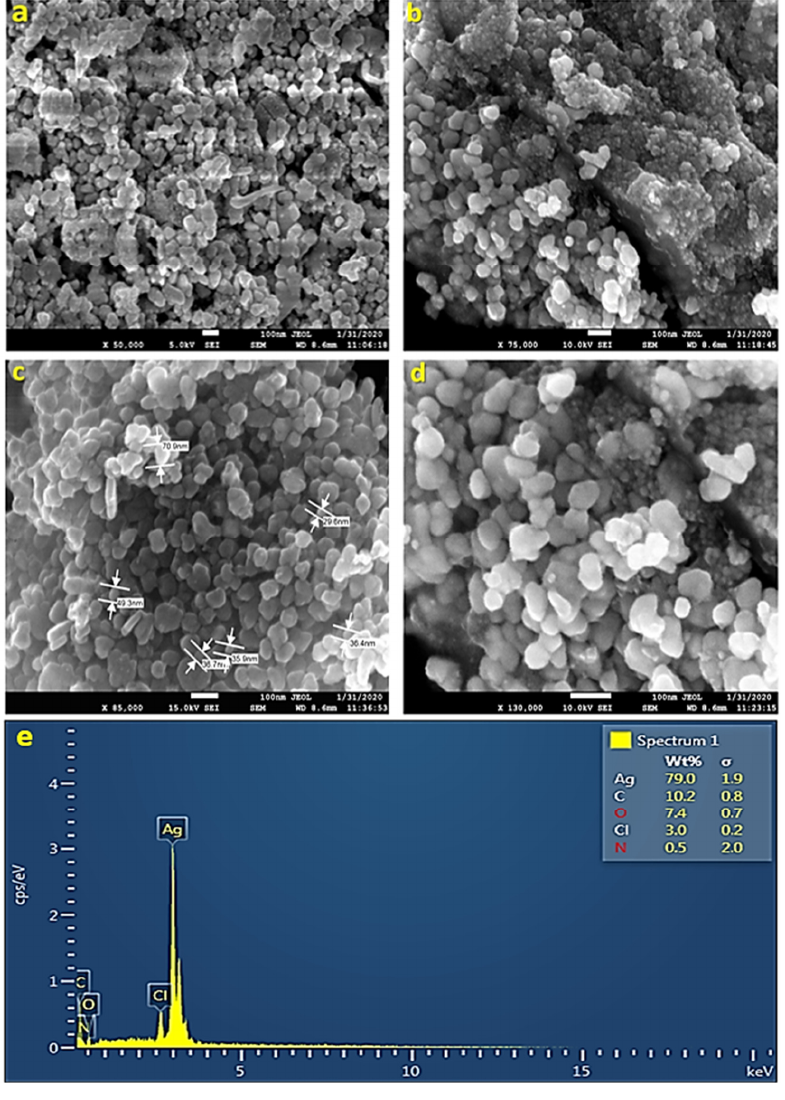
Figure 5. SEM-EDX spectra of biosynthesized silver nanoparticles. SEM images ( a – d ) of the AgNPs demonstrate that their spherical shape ranges from 29 to 70 nm in size. An elemental analysis of AgNPs was confirmed by EDX ( e ), which reveals that 79% of the material is made up of Ag. A strong peak signal was observed at 3 KeV, which is characteristic of metallic AgNPs